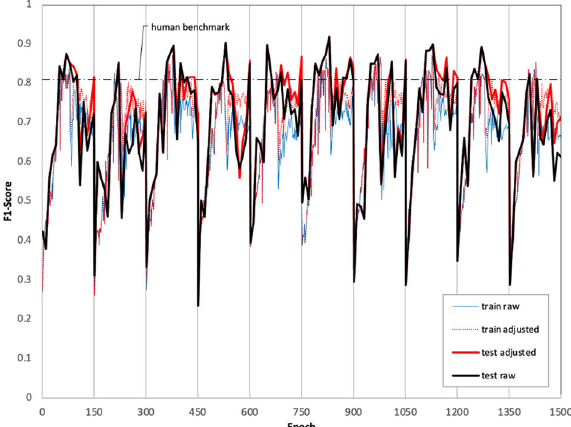
Fig. 2 Variational model F1-Scores during training. F1-Scores evaluated on the training and test sets during tenfold cross- validation